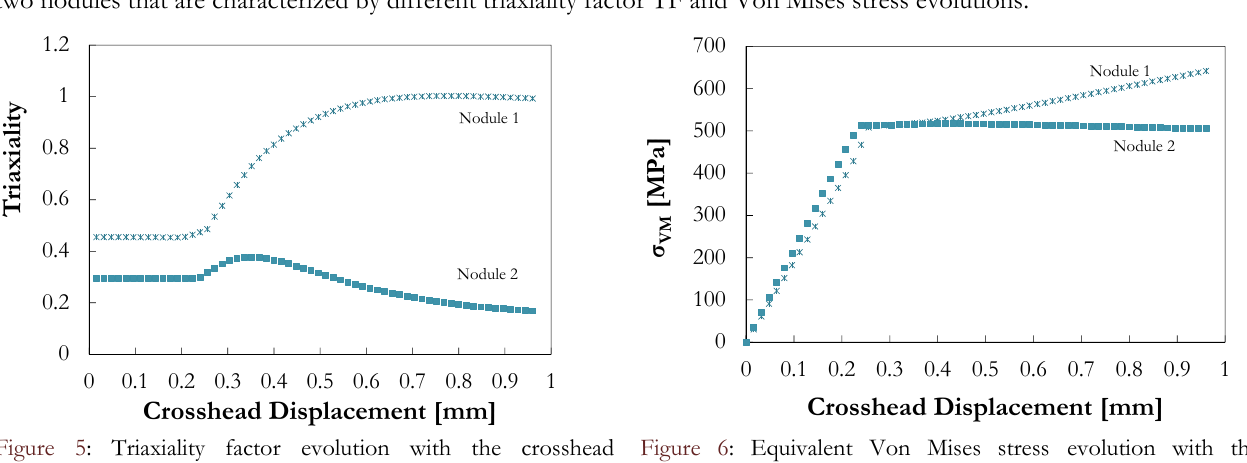
Figure 5: Triaxiality factor evolution with the crosshead displacement.